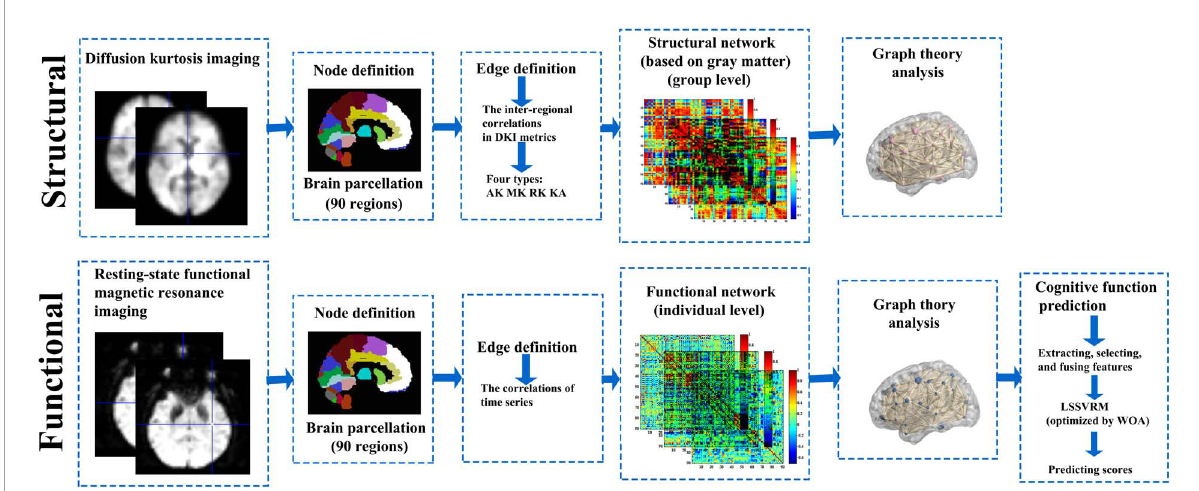
FIGURE1 Research framework. GM and functional brain networks were explored using graph theory through the following four steps: (1) define the network nodes. These were defined as anatomically defined regions of the AAL template; (2) estimate a continuous measure of association between nodes. These were the interregional correlations in DKI metrics and time series data; (3) generate an association matrix by compiling all pairwise associations between nodes, and apply a threshold to each element of this matrix to produce a binary adjacency matrix; and (4) calculate the network parameters of interest in this graphical model of the brain networks and compare them to the equivalent parameters of a population of random networks. GM, gray matter; AAL template, automated anatomical labeling template; DKI, diffusion kurtosis